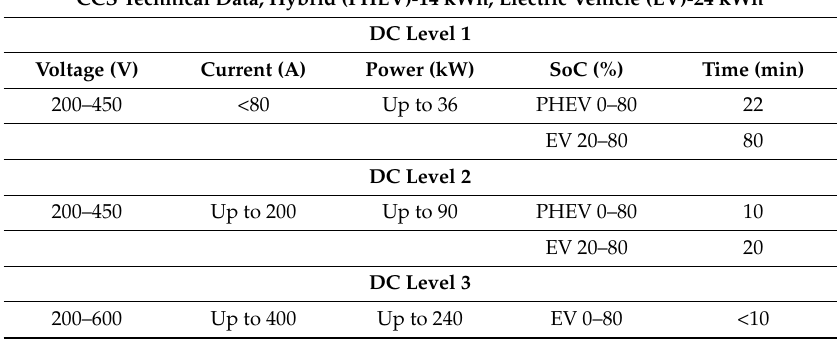
Table 3. CCS (combined charging system) technical